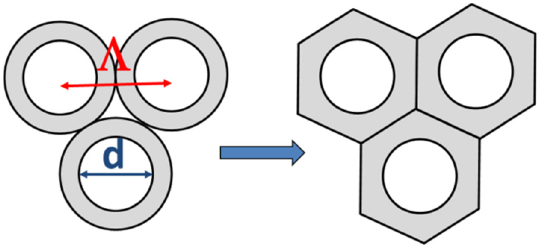
Figure 5. Schematical drawing of geometrical conditions ( left ) before and ( right ) after